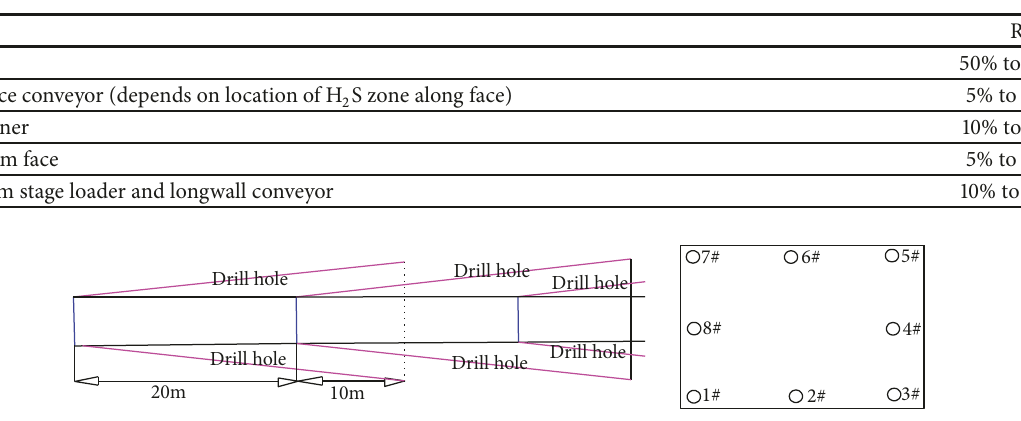
fluid flowed from the even boreholes into an underground tank for pumping to the surface. On the surface neutralization occurred and sulfides present in the fluid broke down